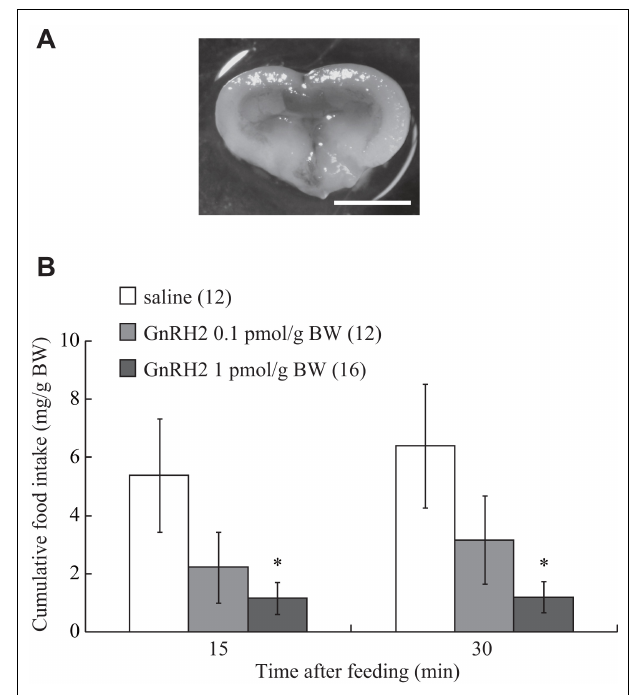
FIGURE 1 | (A) A photograph showing ICV administered-solution containing 0.05% Evans Blue into the brain. Scale bar is 1 mm. (B) Effect of ICV administration of GnRH2 on food intake in the zebrafish. Each column and bar represents the mean and SEM, respectively, and the numbers in parentheses in the panels indicate the number of fish in each group. Significances of differences at each time point were evaluated by one-way ANOVA with the Bonferroni’s method in comparison with the vehicle- injected group (** P <